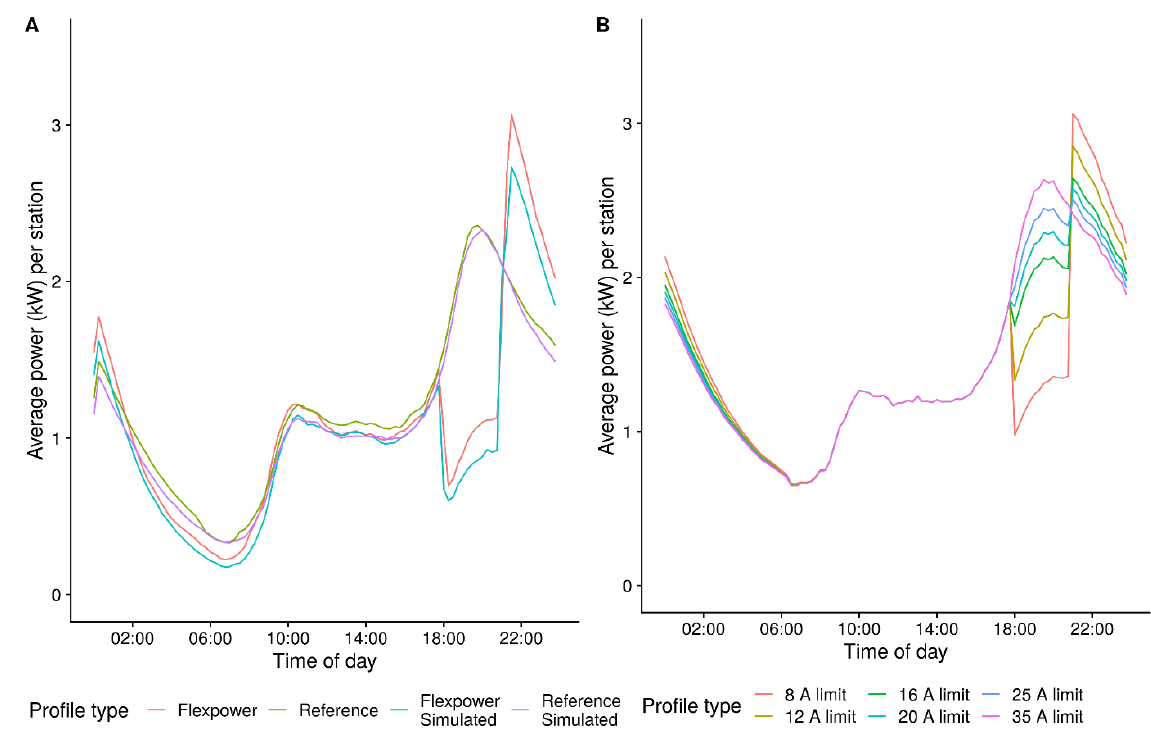
Figure 6. ( A ) Average charging power per station for the actual data on Flexpower and reference stations, as well as a simulation of the Flexpower and reference profiles on the same transactions. ( B ) Simulations of the average charging power per station on a fixed set of transactions using different current limitation levels during the evening hours (18:00–21:00).